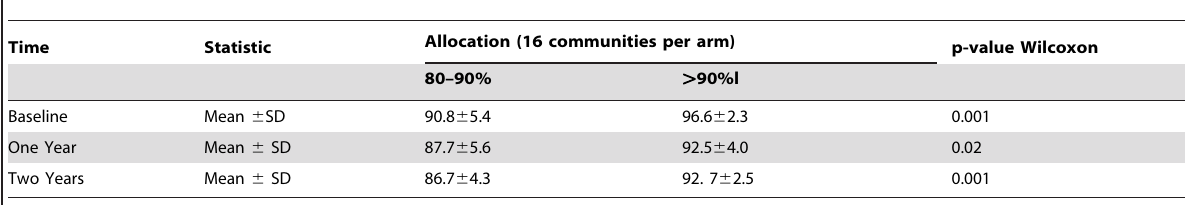
Table 2. Treatment coverage in children under 10 years of age by randomization